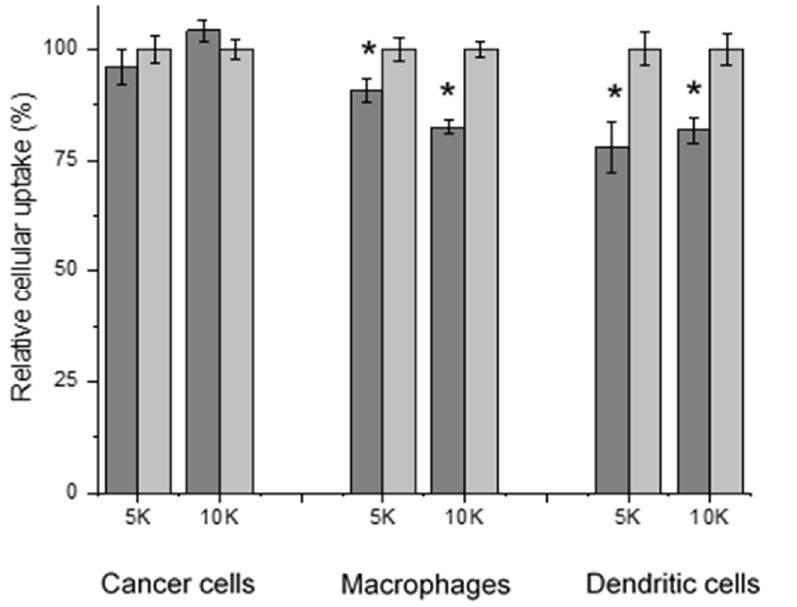
Figure 5. Cellular uptake of Nile red loaded in mPEG5K-zein (“5K”) and mPEG10K-zein (“10K”) micelles precoated with HP (gray) or glucose 5% ( w / v ) solution as control (light gray), by B16-F10-luc-G5 cancer cells, macrophages, and dendritic cells ( n = 6) (*: p < 0.05, compared with controls without protein corona).